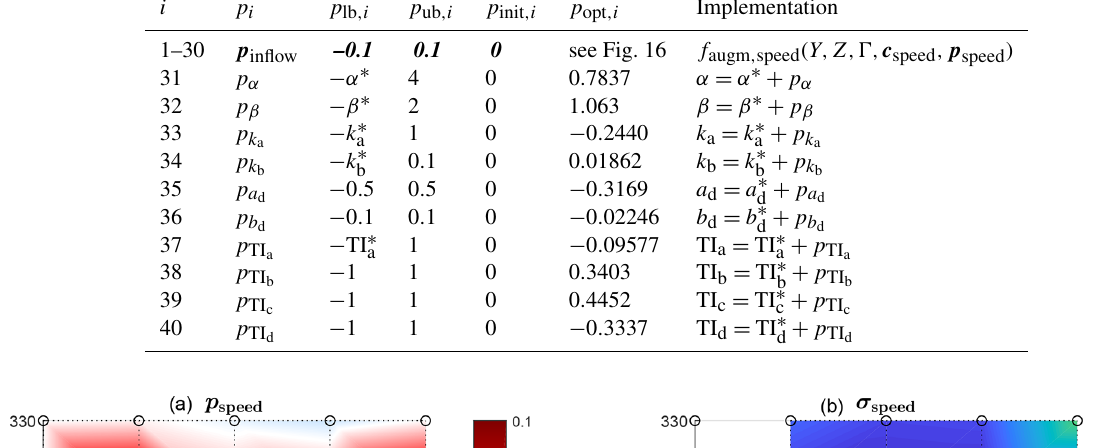
Table 7. Definition of the parameters, together with their lower and upper bounds, and initial and identified values. Bold italic numbers indicate vectors containing that number repeated as many times as the vector length.